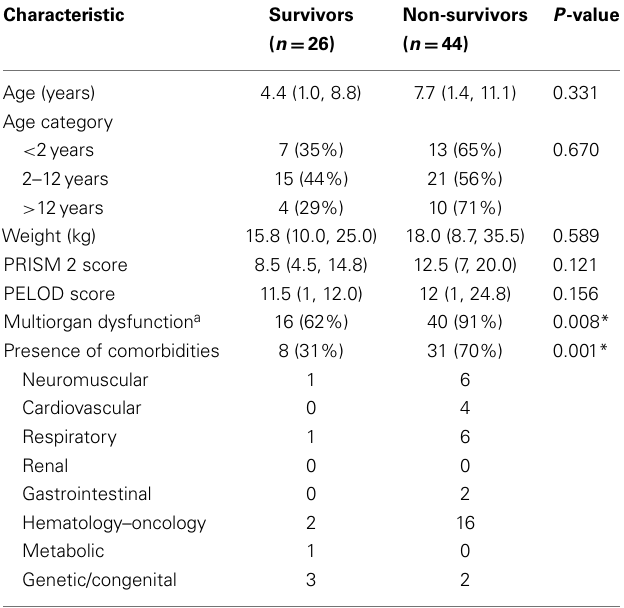
Table 2 | Characteristics of pediatric patients withALI/ARDS .